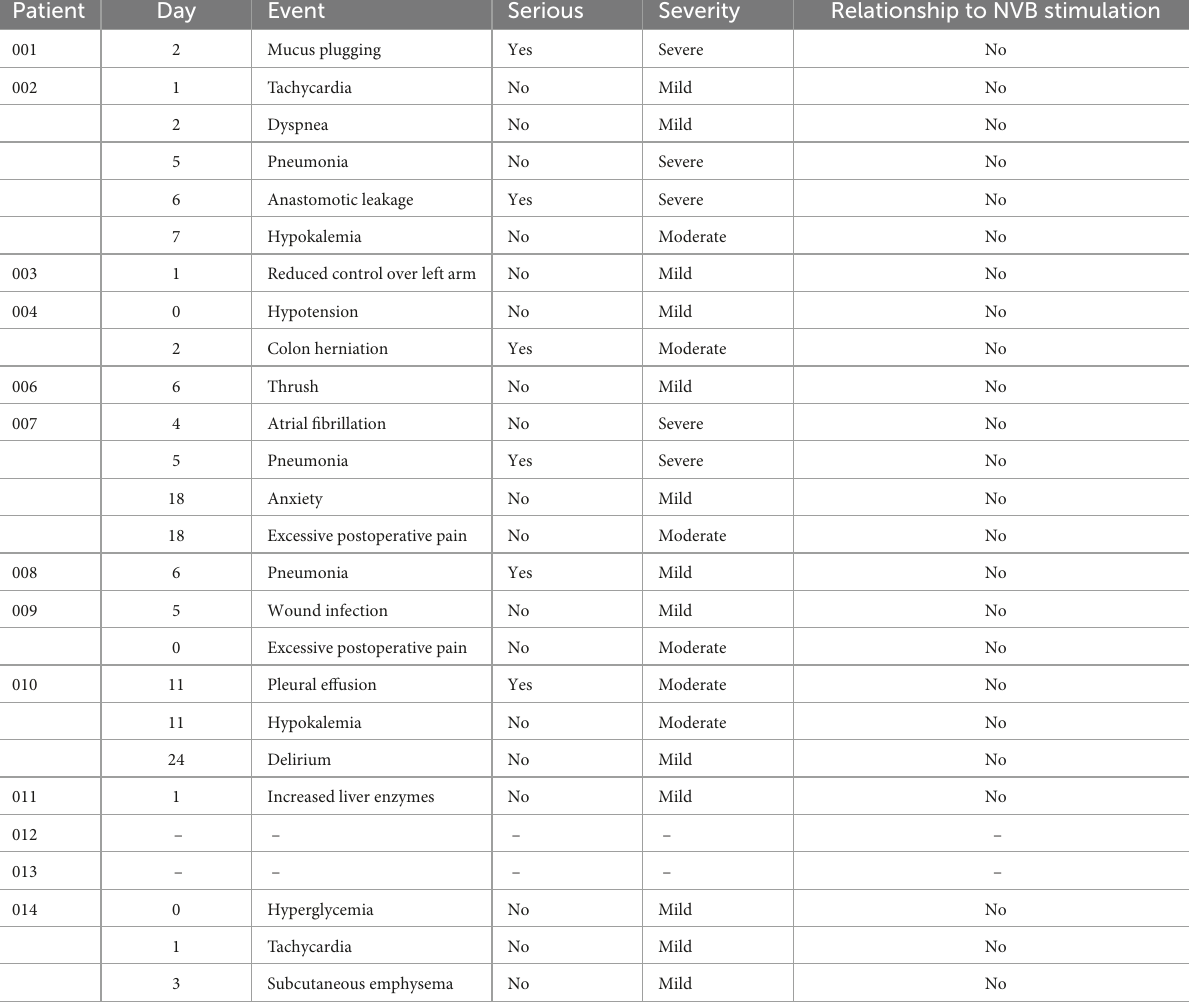
TABLE 3 Adverse